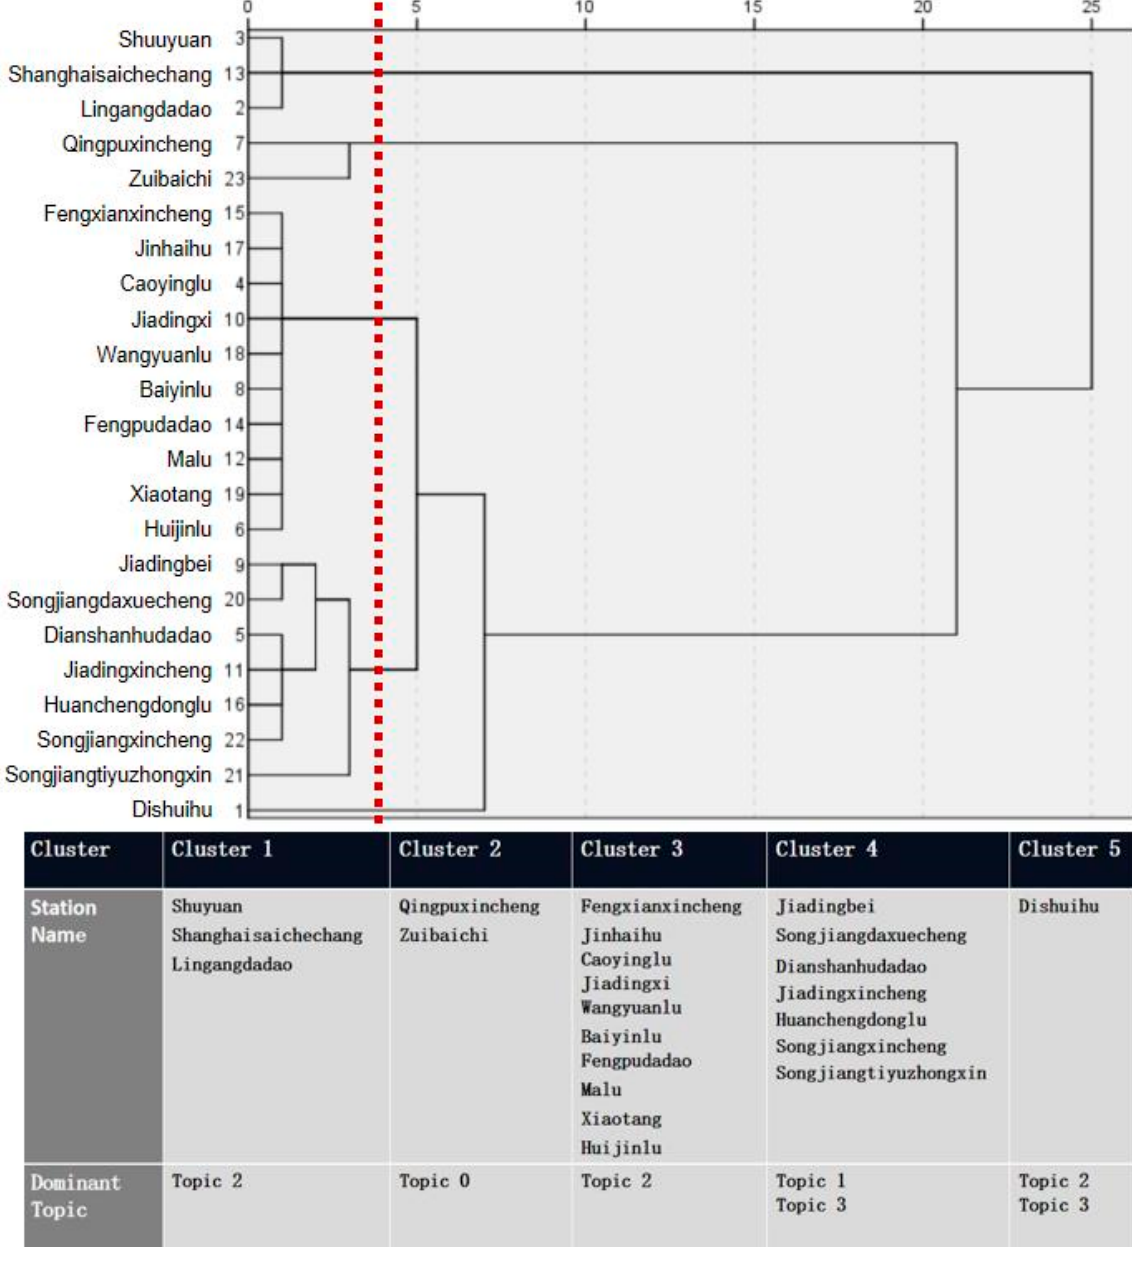
Figure 5. Hierarchical clustering results of station based on standard deviation metric.